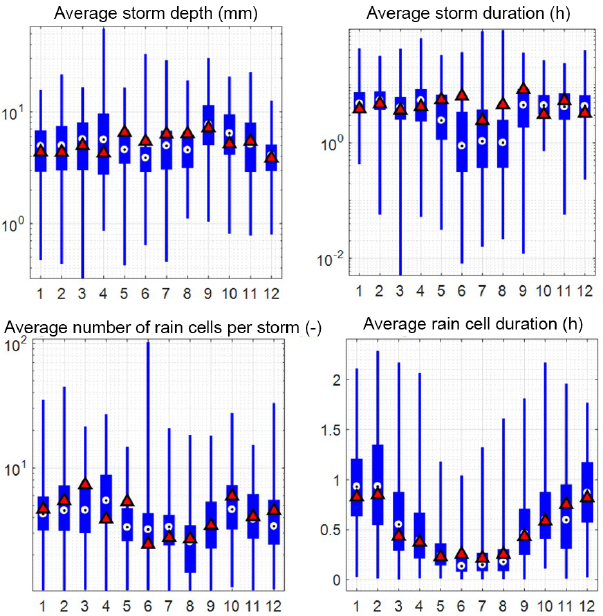
Figure 18. Variability of the rainfall characteristics of the MBLRP model of this study (box plot) at gauge NCDC-460582 (star mark in Fig. 3). The rainfall characteristics of the traditional MBLRP model are shown together for reference